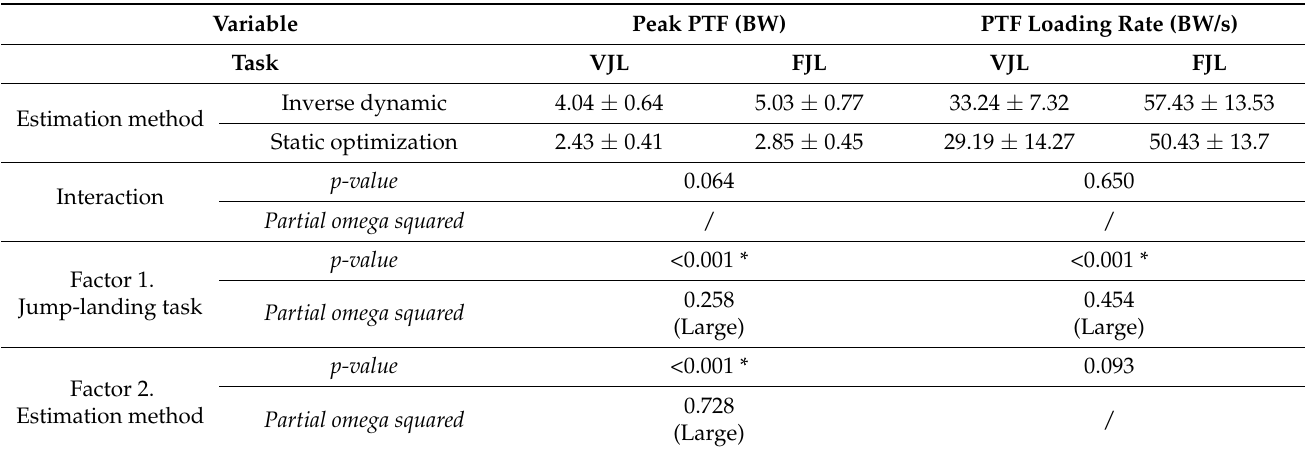
Table 1. Mean ± standard deviation of patellar tendon force (PTF) parameters estimated through inverse dynamic and static optimization methods for volleyball players during vertical (VJL) and forward (FJL) jump-landings.